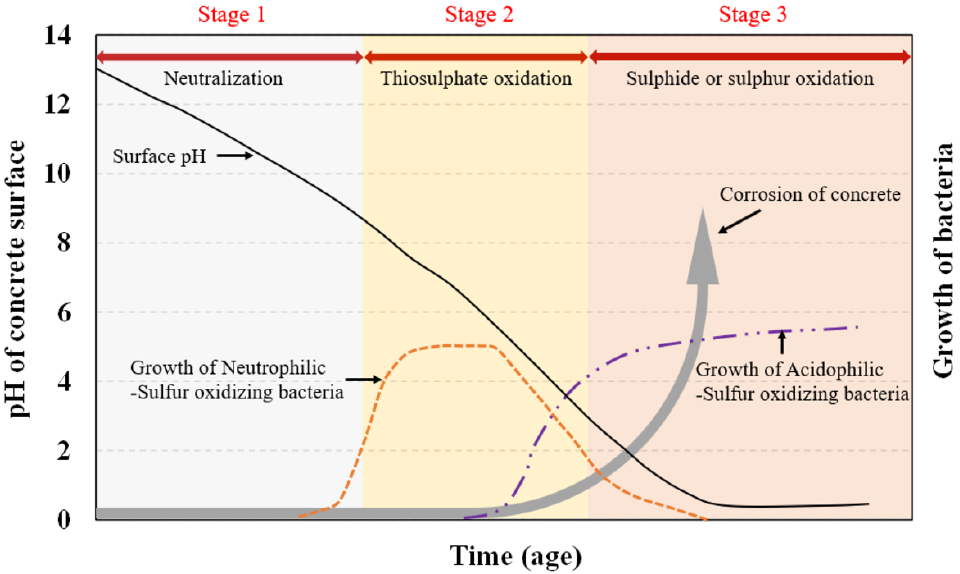
Figure 2. Stages of biocorrosion in concrete [33].